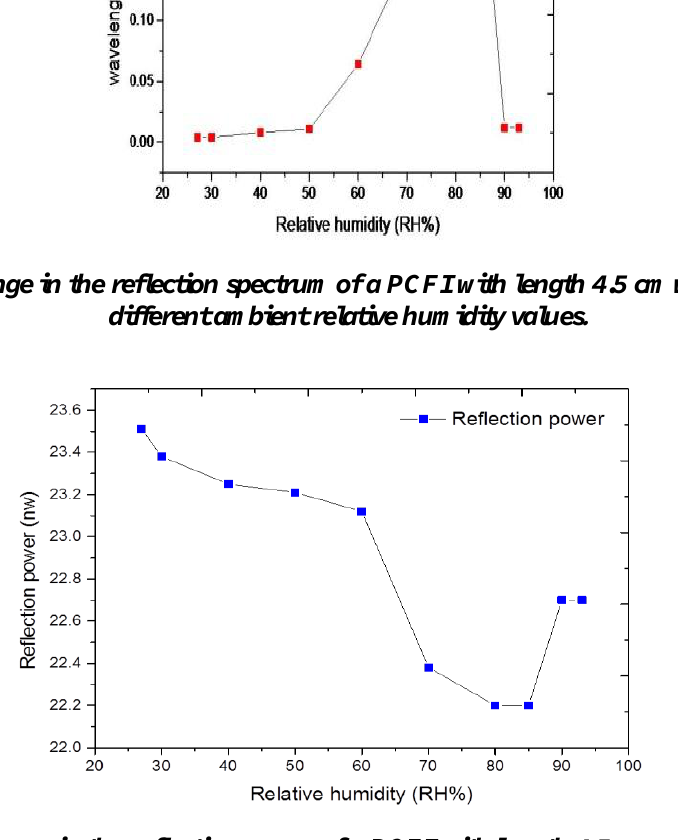
Fig. 3: Change in the reflection power of a PCFI with length 4.5 cm with respect to different ambient relative humidity values